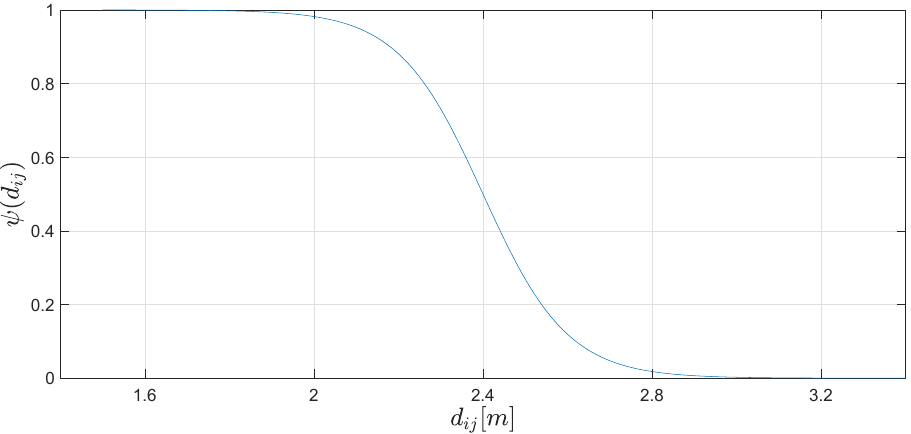
Figure 5. Switching function to turn on/off the repulsive vector fields. A function which satisfy con- ditions given in Section II, with the same behaviour, could also be used instead of the proposed